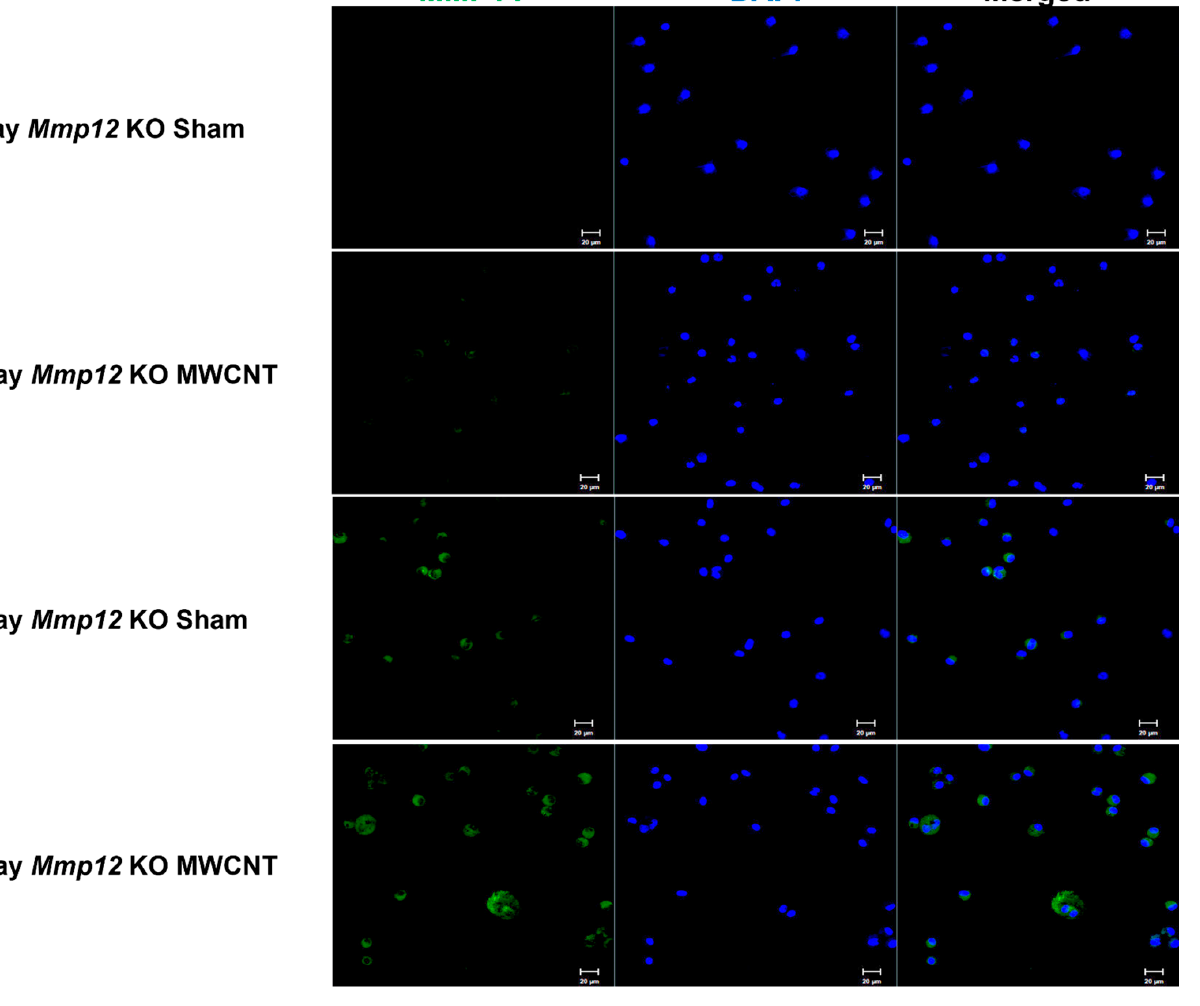
Figure 6. MMP14 protein increased in Mmp12 KO mice at 60 days. ICC staining showed increased MMP14 expression on BAL cells from Mmp12 KO mice at 60 days relative to 10 days. Additionally, Mmp12 KO mice instilled with MWCNT expressed MMP14 at higher levels than in sham-instilled Mmp12 KO mice. Representative images of n ≥ 3 animals.